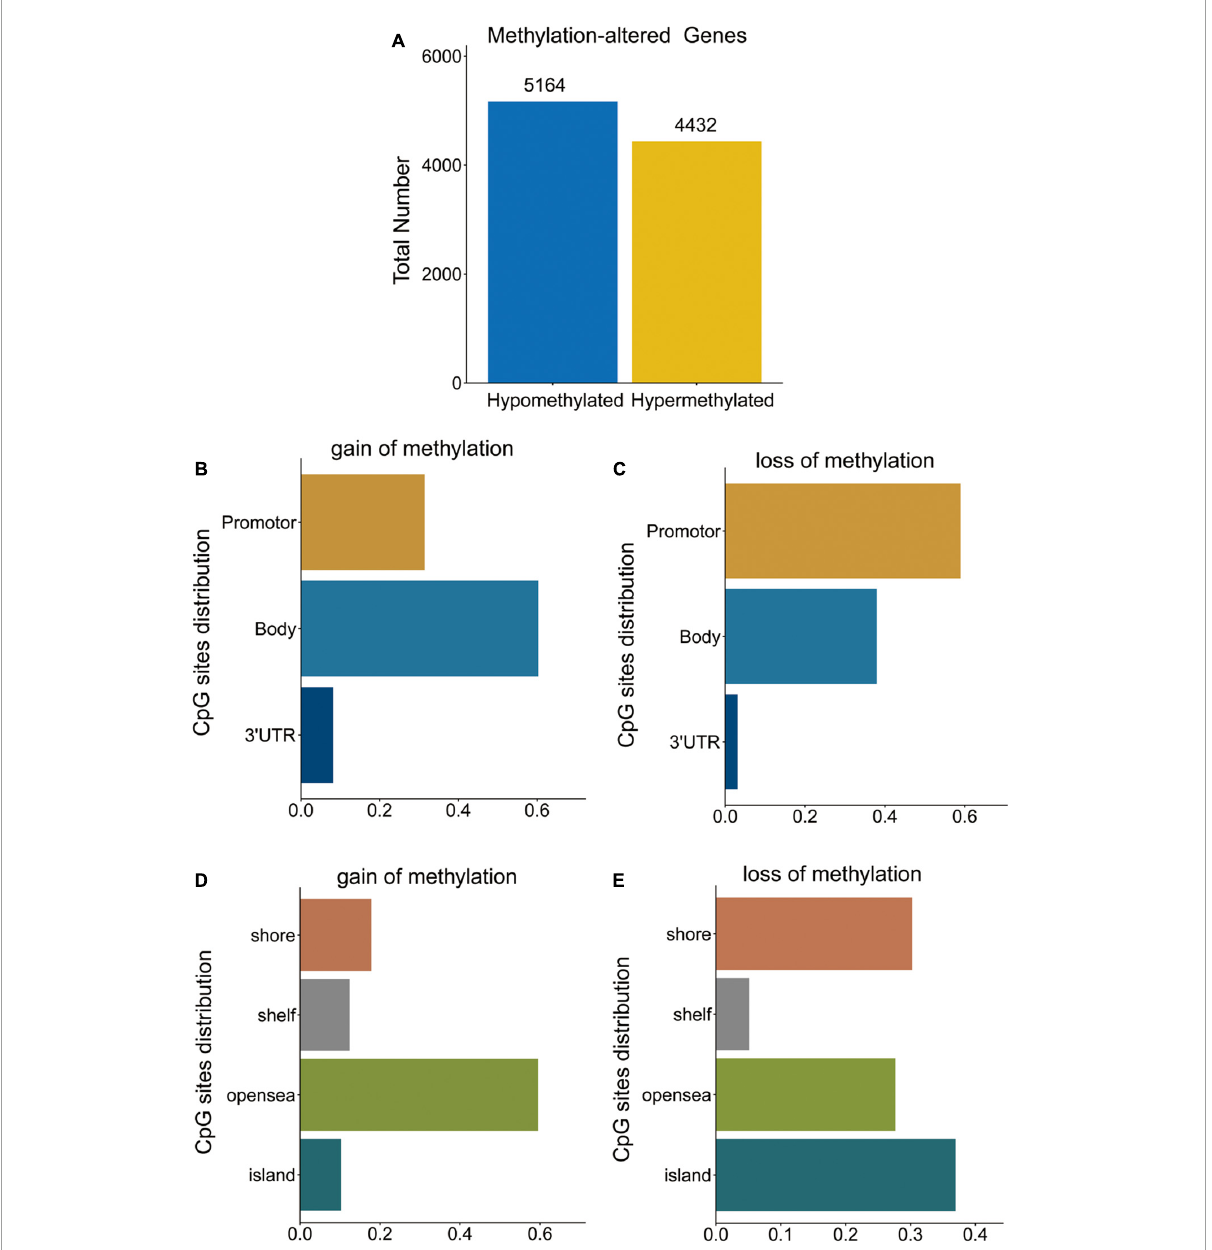
FIGURE1 DMGs in PD patients. (A) Bar plot for DMGs in PD patients and healthy controls. (B,C) Distribution of DNA methylation changes in all genomic compartments. (D,E) Distribution of DNA methylation changes in varying CpG content and neighborhood